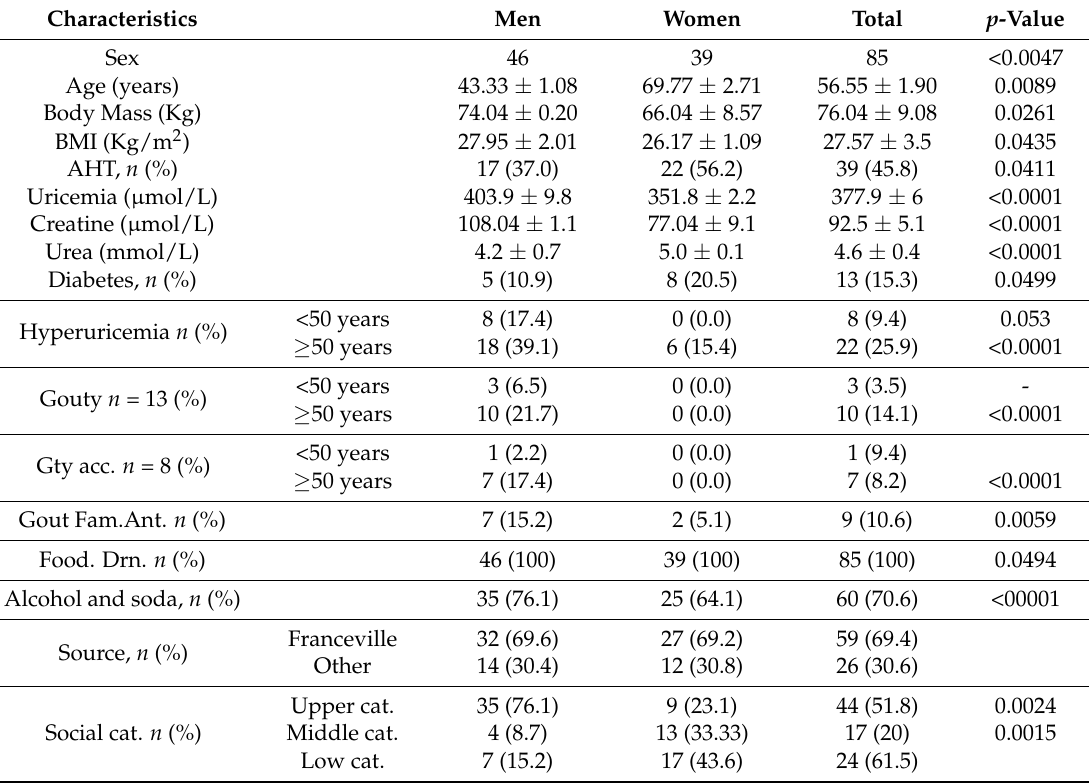
Table 1. General characteristics of the study